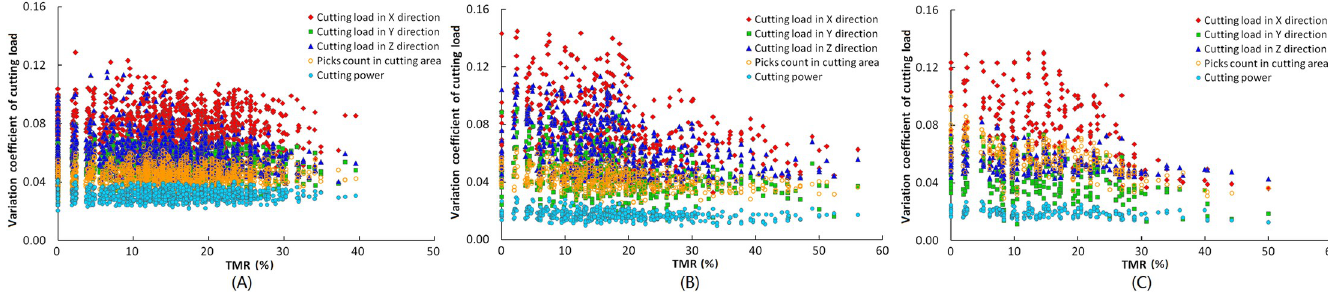
Fig 12. Relationship between CV of cutting load and TMR of each cutting head. (A) 2-helices cutting head. (B) 3-helices cutting head. (C) 4-helices cutting